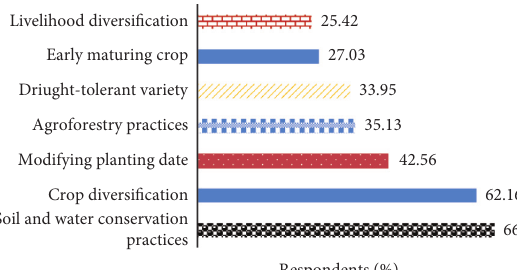
Figure 7: Adaptation strategies used by farmers in Southwest